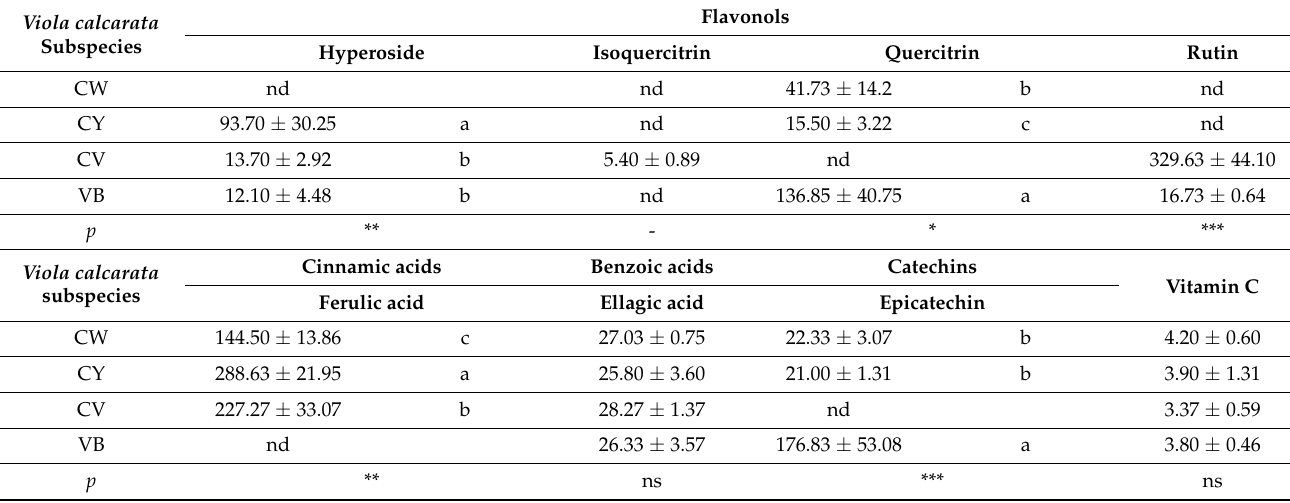
The statistical relevance is provided (*** = p < 0.001; ** p < 0.005; * p < 0.05; ns = not significant). Different letters inside a column indicate significant differences between the subspecies according to Tukey’s post-hoc test ( p < 0.05); nd: not